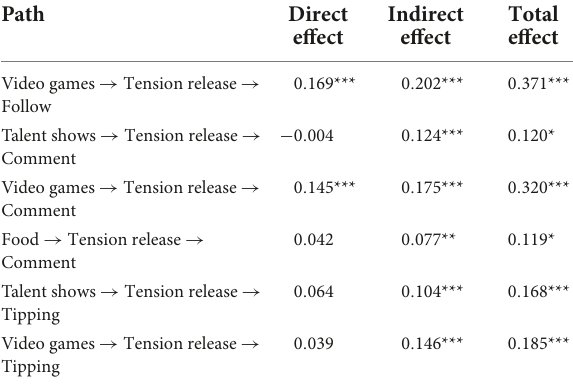
TABLE 5 Direct, indirect, and total